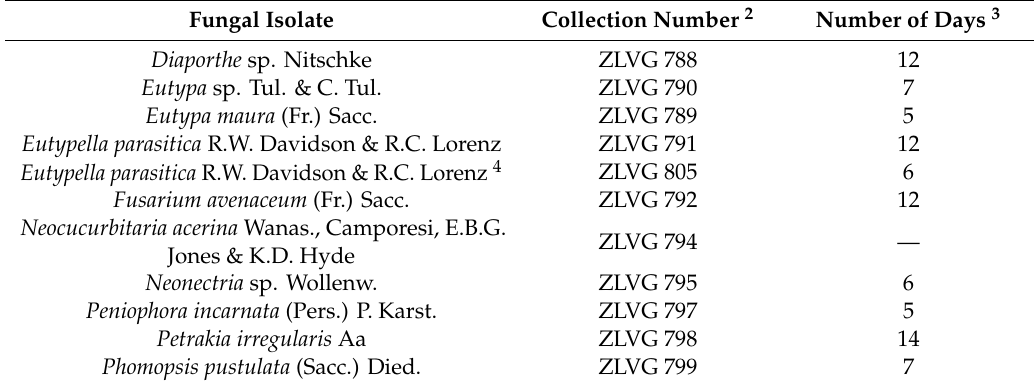
Table 1. Fungal isolates 1 used in dual cultures assays.